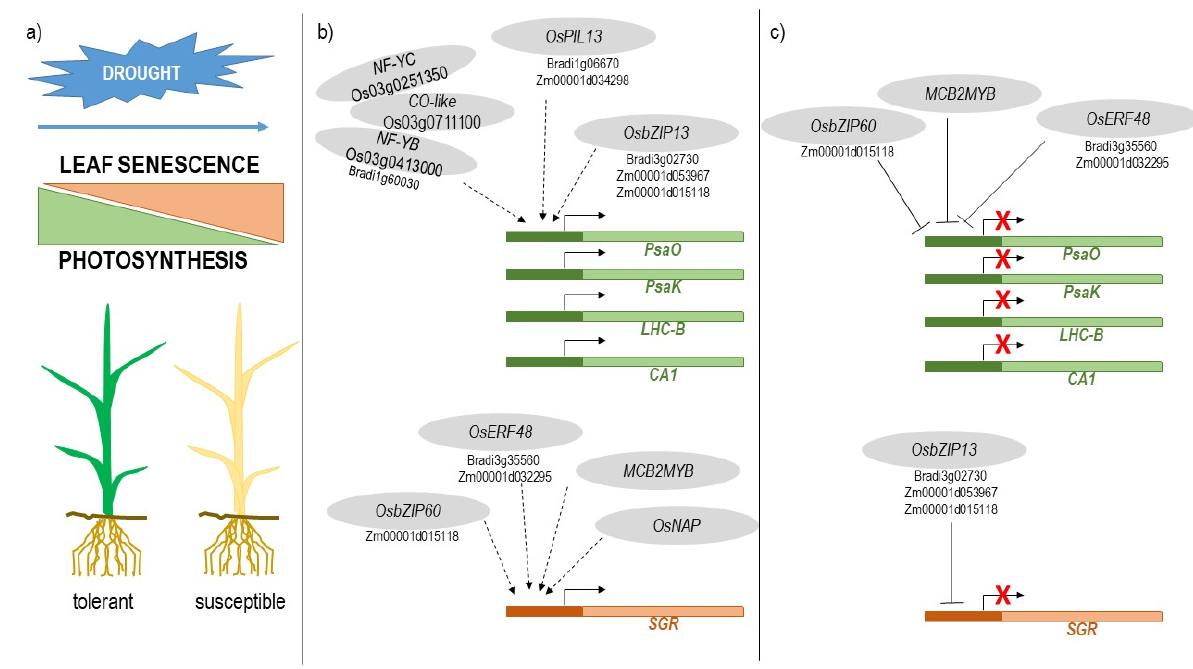
Figure 6. Proposed model for the differentiation of tolerant and sensitive response to drought stress in cereals. ( a ) The balance between induction of leaf senescence and maintenance of photosynthesis during drought is crucial for tolerance and is obtained through fine-tuning of gene expression by specific transcription factors (TFs). ( b , c ) The putative rice TFs involved in the regulation of genes related to photosynthesis ( Psao , PsaK , LHCB, and CA1 ) and leaf senescence ( SGR ) are represented. Some of them may act as positive ( b ) or negative ( c ) regulators. When identified, putative barley and maize orthologues of rice TF-encoding genes are indicated.